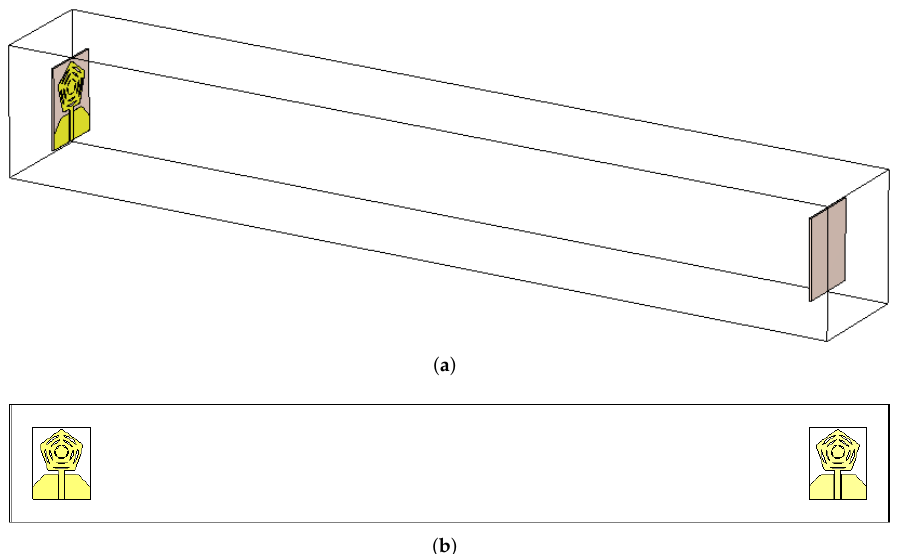
Figure 10. ( a ) Face-to-face and ( b ) side-by-side configuration for the evaluation of time domain performance of the proposed antenna CPW-fed pentagonal fractal